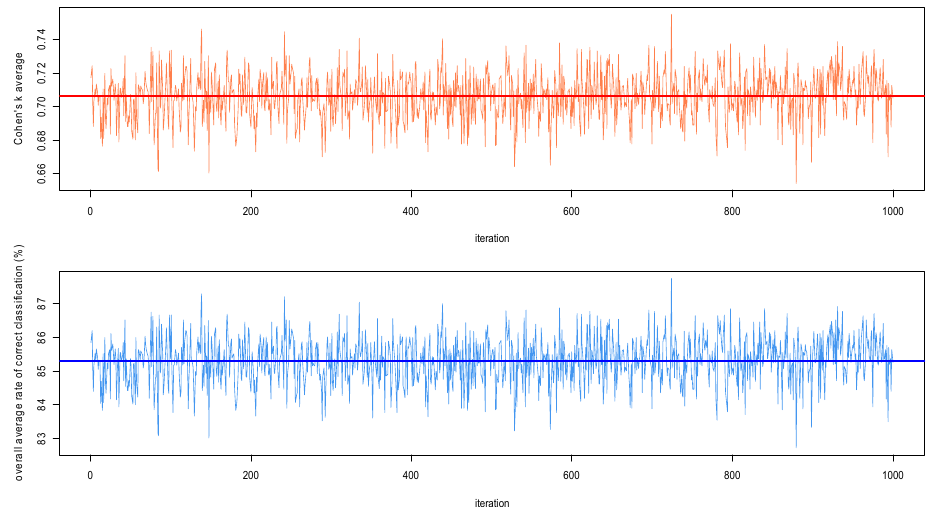
Figure 2. Results of the Monte Carlo validation assessing the performances of the classifier Φ (cid:2947) . The graphs show the averages of the Cohen’s k and of the overall rate of correct classification achieved by Φ (cid:2947) at each iteration of the 10 3 applications of Λ (cid:3107) . Horizontal thick lines indicate the overall averages.